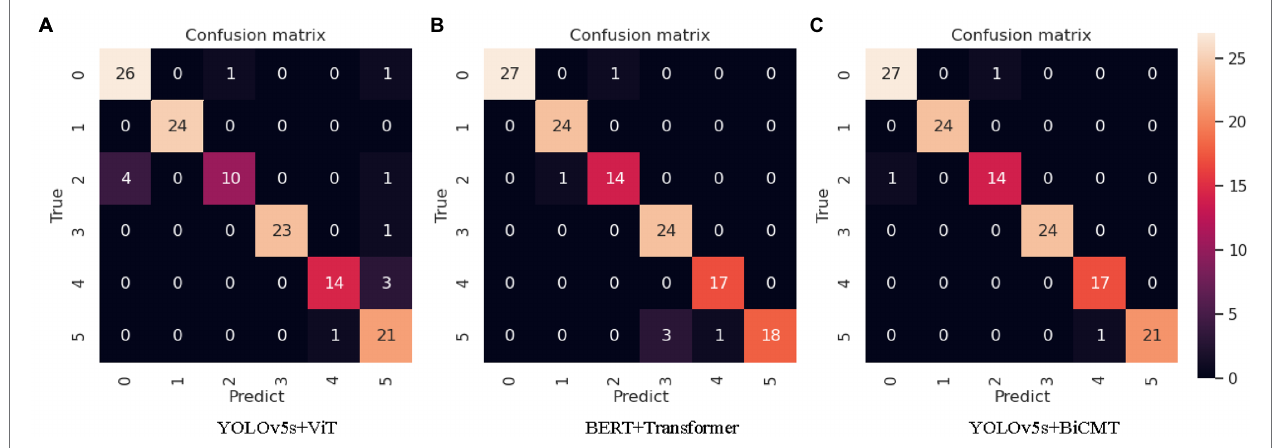
FIGURE 7 | Confusion matrices of the identification results of each model. Note: “0” refers to “tomato powdery mildew”; “1” refers to “tomato early blight”; “2” refers to “tomato virus disease”; “3” refers to “cucumber powdery mildew”; “4” refers to “cucumber virus disease”; “5” refers to “cucumber downy